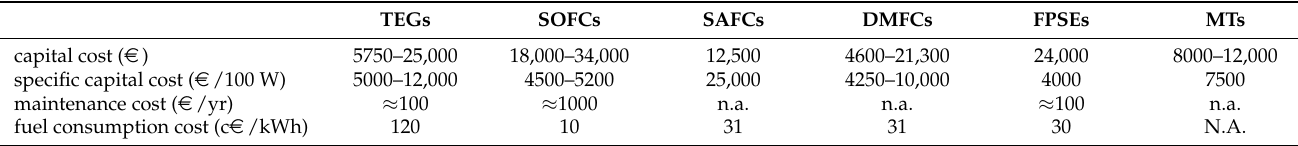
Table 3. Economic features of TEGs, SOFCs, SAFCs, DMFCs, FPSEs and MTs.